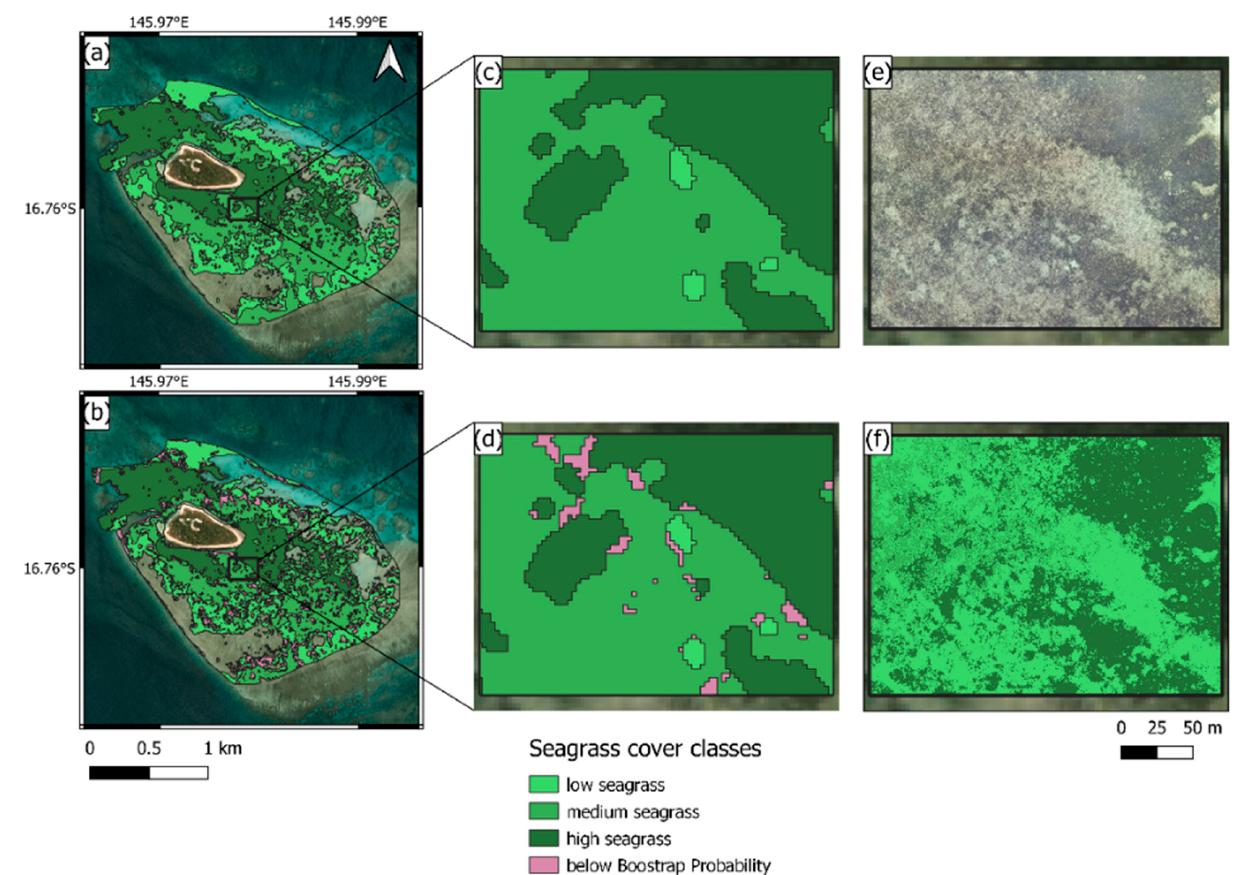
Figure 10. Machine ‐ and deep ‐ learning approaches to fine ‐ scale mapping of seagrass abundance classes in an intertidal/shallow subtidal reef habitat, Green Island, in 2020: ( a ) abundance classes of seagrass mapped with bootstrap probability of 60%, from spaceborne ‐ captured imagery using machine ‐ learning; ( b ) abundance classes of seagrass mapped with bootstrap probability of 100%, from spaceborne ‐ captured imagery using machine ‐ learning; ( c ) highlighted AOI showing detail of machine ‐ learning derived map with bootstrap probability of 60%; ( d ) highlighted AOI showing detail of machine ‐ learning derived map with bootstrap probability of 100%; ( e ) highlighted AOI showing the UAV ‐ captured imagery; ( f ) highlighted AOI showing abundance classes of seagrass mapped with deep ‐ learning from UAV ‐ captured imagery. Table 7. Area of seagrass abundance classes (hectares) mapped within each AOI at reef and coastal clear water habitats using imagery captured with satellite (PlanetScope) and UAV. BP = bootstrap probability, * = below bootstrap probability (bBP). AOI for meso ‐ scale spaceborne ‐ captured imagery can differ due to kernelling at the margins of the AOI. n.a. = not assessed. NB: reef clear water meadow covers entire AOI, with no meadow boundary mapped by foot.